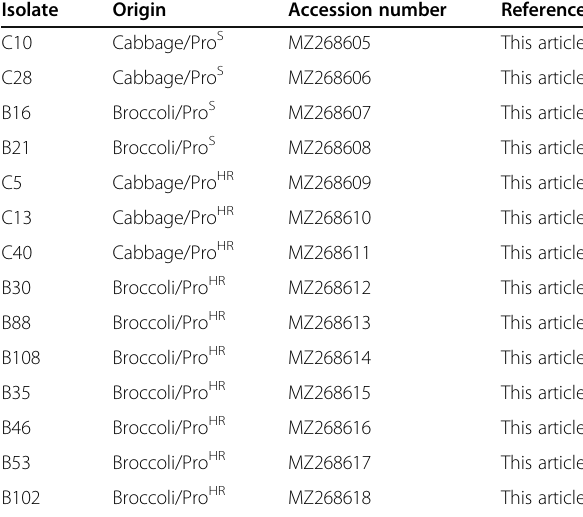
Table 5 Nucleotide sequence accession numbers corresponding to AaHK1 from Pro HR and Pro S isolates of Alternaria alternata in this study